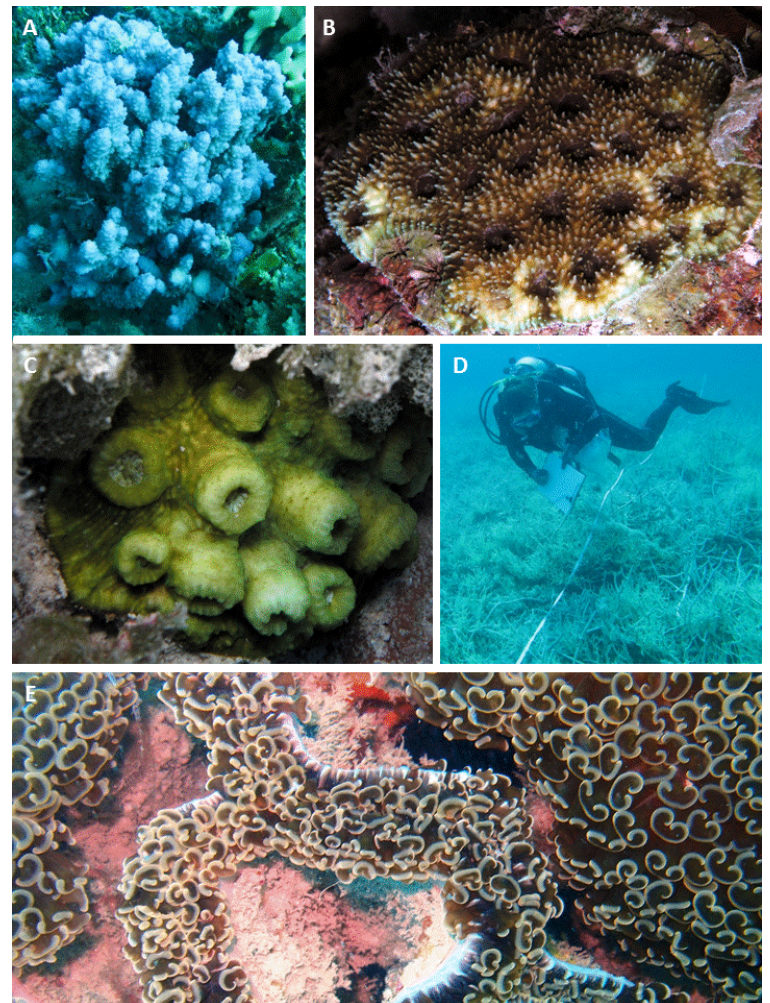
Figure 2. New scleractinian coral records from the Marshall Islands. ( A ) A single colony of Anacropora reticulata was located in the lagoon at Rongerik Atoll. ( B ) Acanthastrea brevis was documented at almost half of the sites surveyed. ( C ) Echinophyllia orpheensis is frequently encountered in overhangs and crevices. ( D ) Acropora loisetteae forming an extensive thicket in the eastern part of Rongelap Lagoon. ( E ) Only a single colony of Euphyllia ancora was observed at a single site at Mili